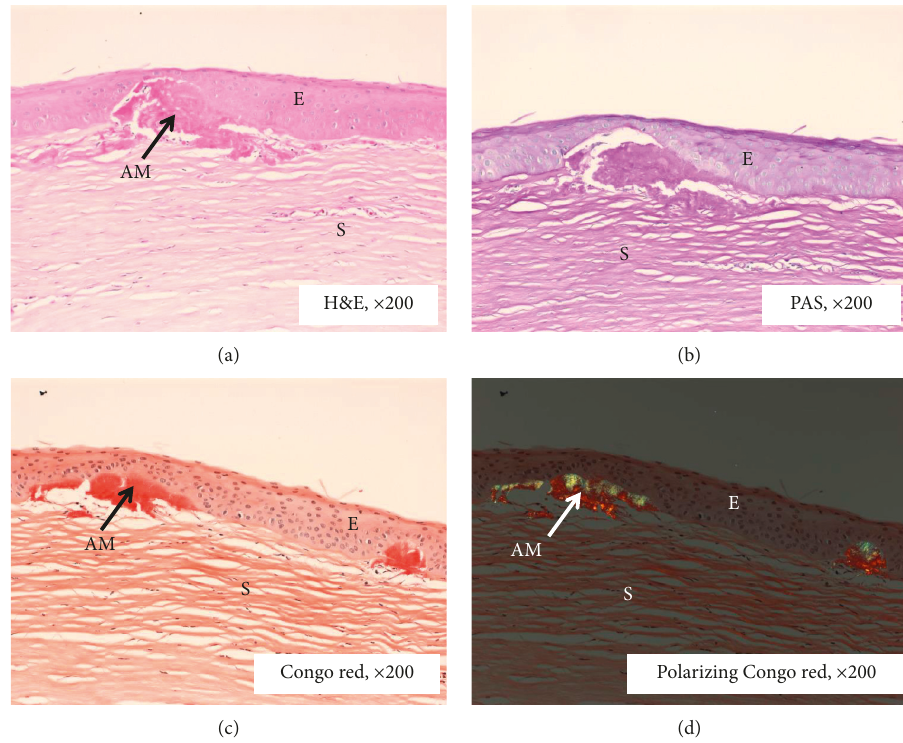
Figure 2: Histopathological analysis of GDLD cornea. (a) The degenerate epithelium, amyloid deposit, and absence of Bowman’s layer and stroma (H and E). Notice the absence of Bowman’s layer. (b) Part of the cornea showing detached epithelium, stroma, and amyloid deposits positively stained with PAS; (c) part of the cornea showing detached epithelium, stroma, and amyloid deposits positively stained with Congo red; (d) part of the cornea showing amyloid deposits with polarizing Congo red. AM: amyloid deposit; E: epithelium; S: